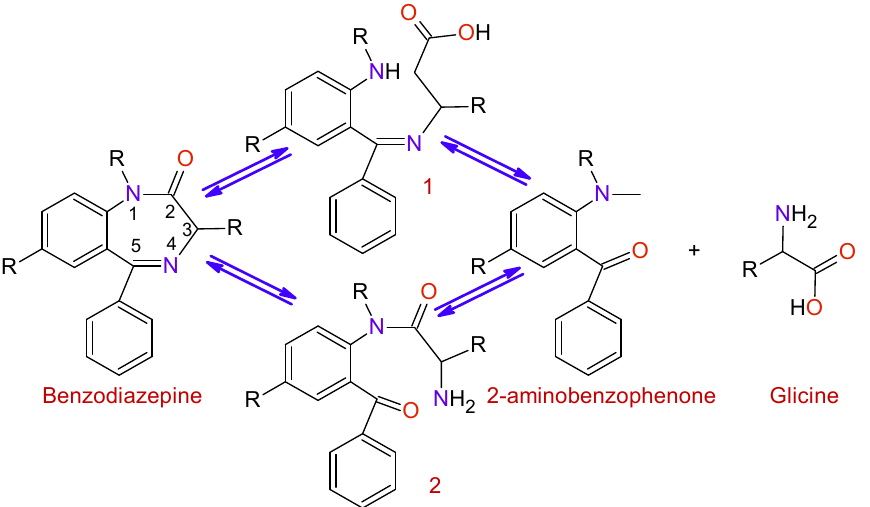
Figure 5. Degradation of benzodiazepines into 2-aminobenzophenone and glycine.